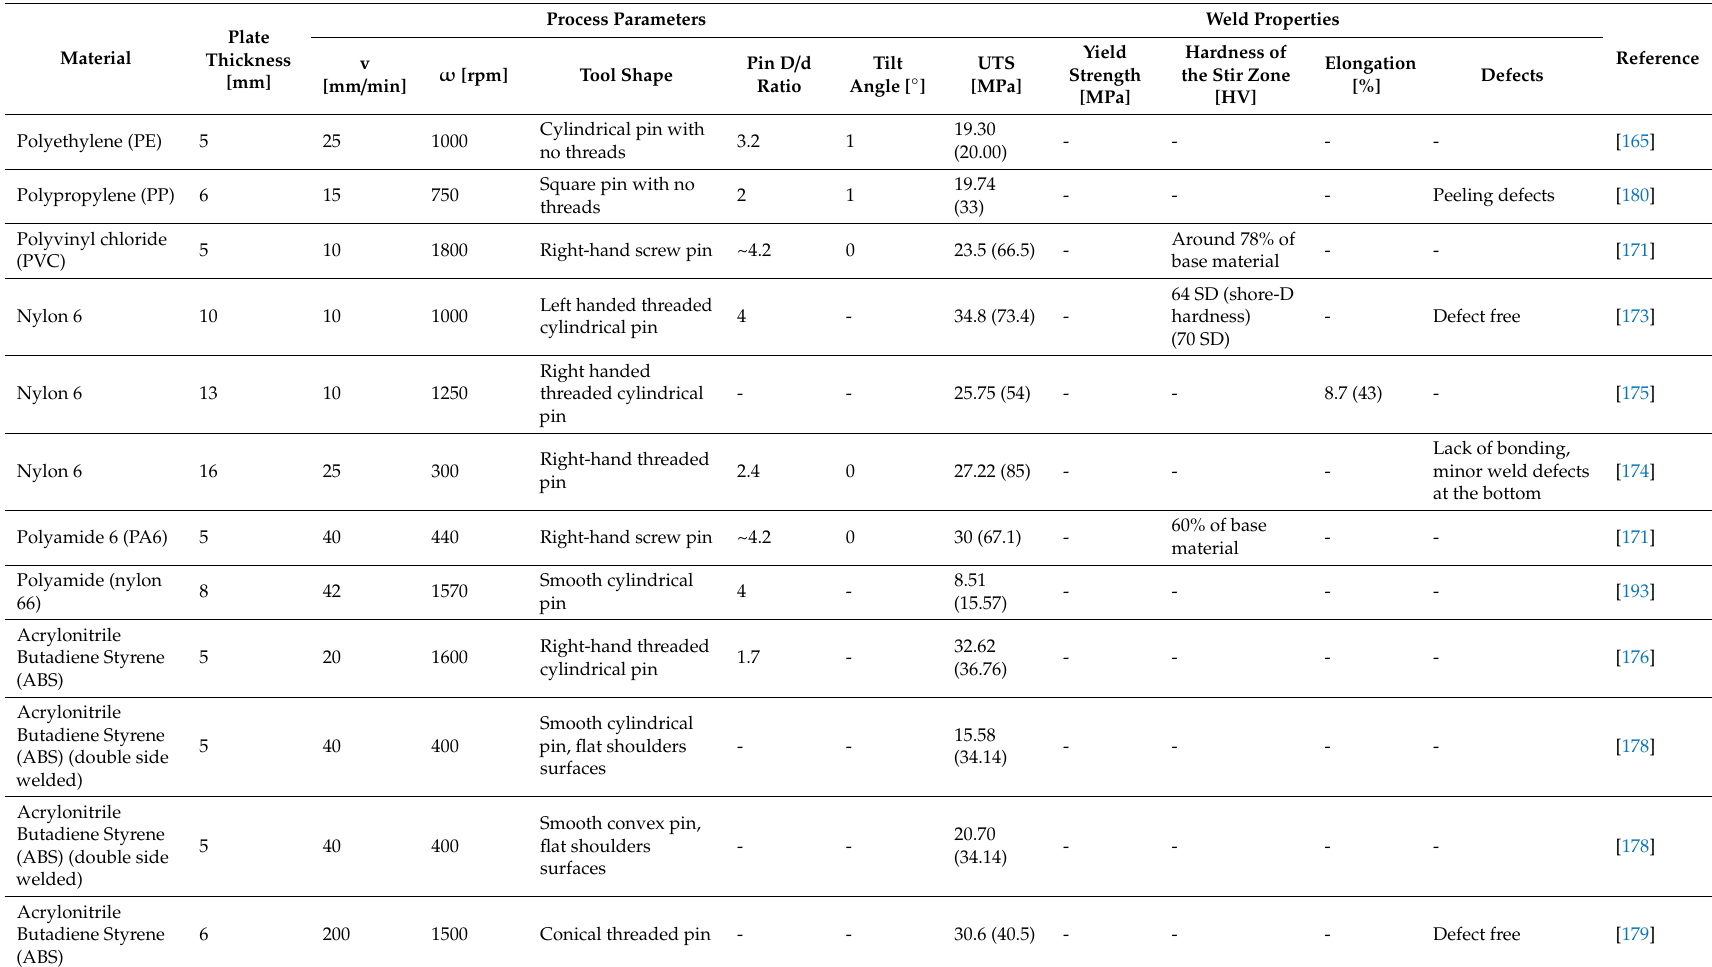
Table 6. FSW of polymers—process parameters and mechanical properties of the